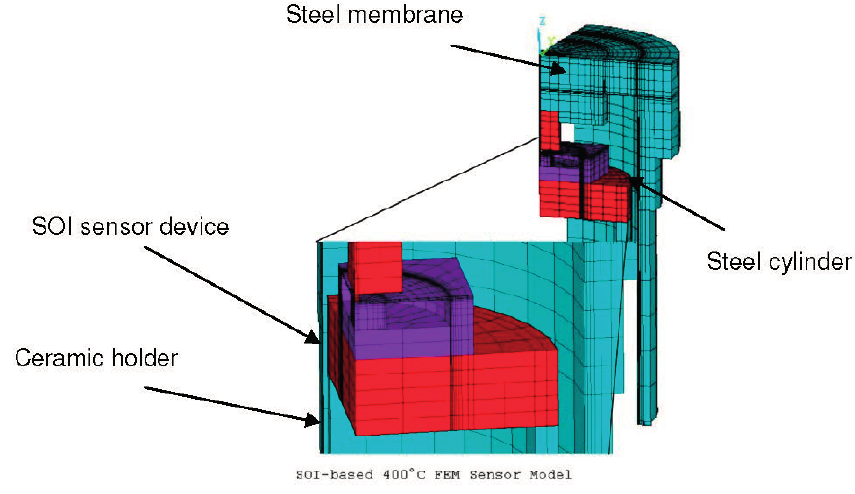
Figure 2. ANSYS FEM model used in this work. Right —quarter model of the sensor system, light blue: steel parts, red: ceramic parts, purple: silicon sensor chip which consists of a centerboss membrane, bonded to a silicon wafer; Left —enlarged model of the SOI sensor device with centerboss and ceramic